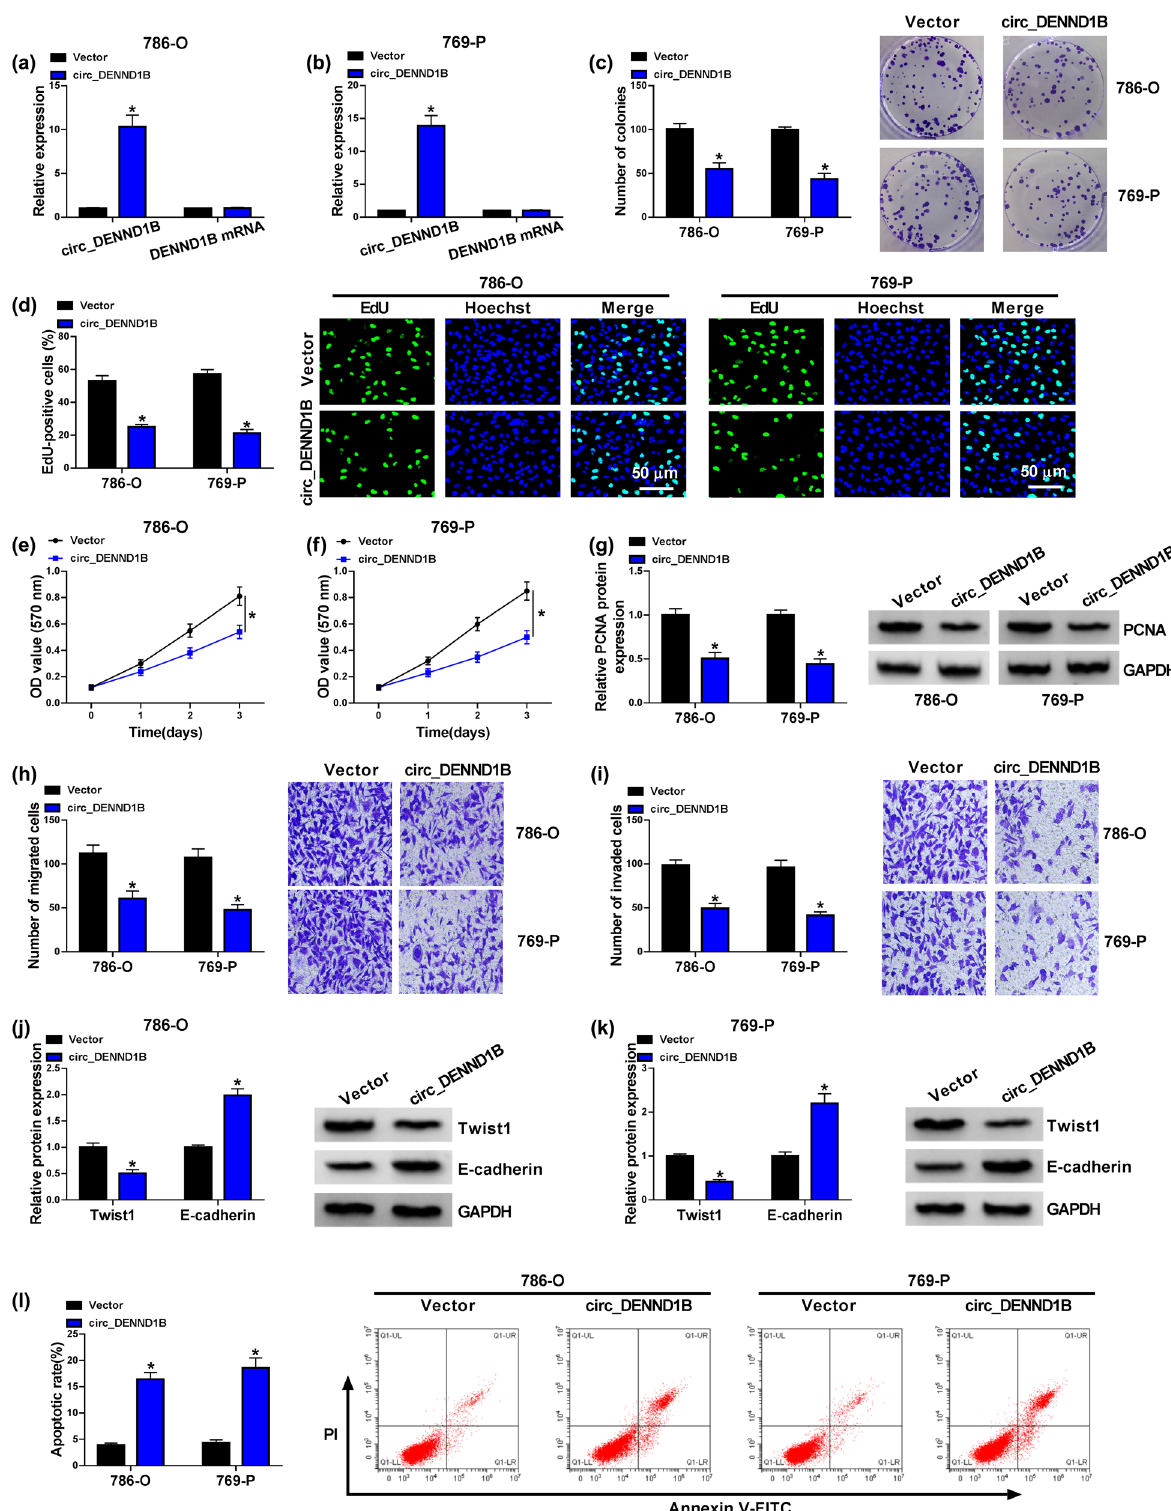
Figure 2: Overexpression of circ_DENND1B suppressed proliferation, migration and invasion of ccRCC cells. ( a and b ) qRT - PCR detected the expression of circ_DENND1B and DENND1B mRNA. ( c ) Colony formation assay detected the number of colonies. ( d ) EdU assay detected the EdU - positive cells. ( e and f ) MTT detected the cell viability. ( g ) Western blot detected the level of PCNA protein. ( h and i ) Transwell assay detected the cell migration and invasion ability. ( j and k ) Western blot detected the level of Twist1 and E - cadherin. ( l ) Cell apoptosis was detected by fl ow cytometry. * P <